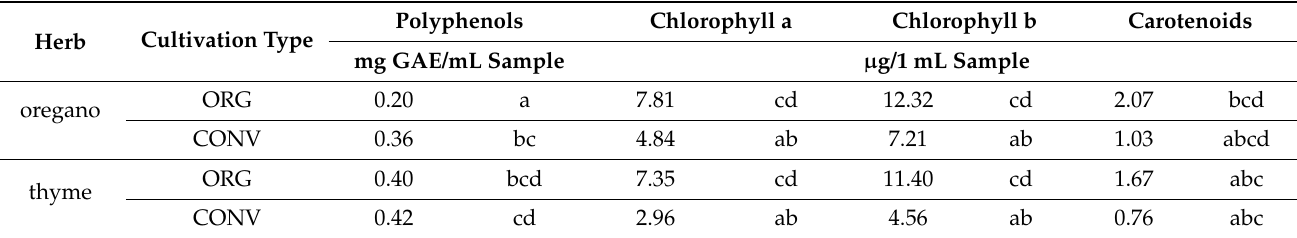
Table 1. The chosen chemical compounds are determined in water macerates of dry oregano and thyme cultivated in conventional (CONV) and organically